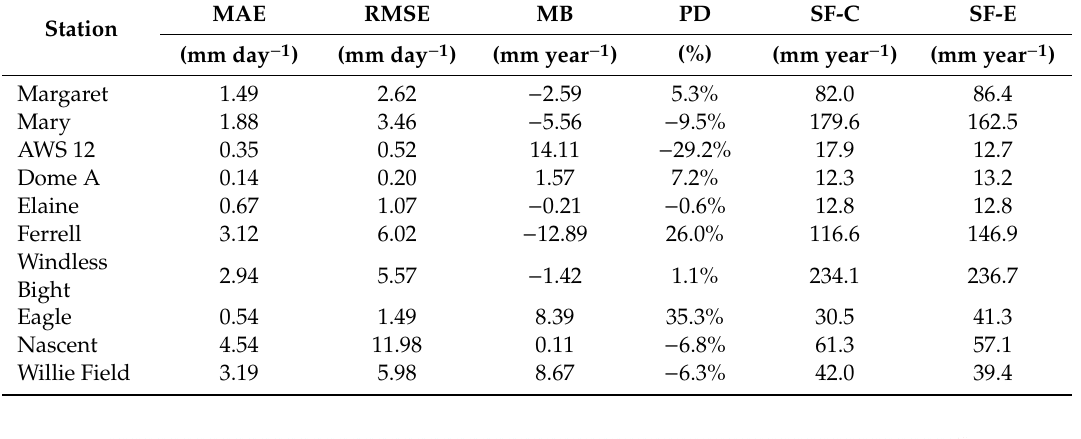
Table 2. Mean absolute error (MAE) (mm day − 1 ) and root mean square error (RMSE) (mm day − 1 ) of the magnitudes of daily CloudSat and ERA5 snowfall (and not the rates of change) for the ten AWS locations. Mean bias (MB) (mm year − 1 ), percentage deviation (PD) and average CloudSat and ERA5 snowfall (SF-C and SF-E) (mm year − 1 ) of the magnitudes of annual CloudSat and ERA5 snowfall for the ten AWS locations.